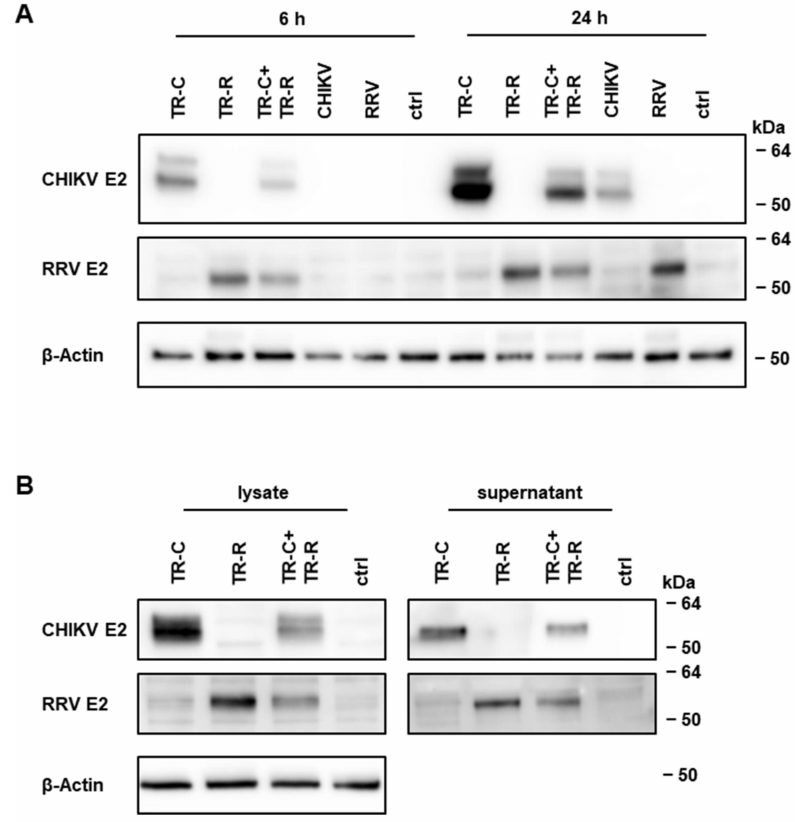
Figure 3. Antigen expression from TR-RNAs. ( A ): CHIKV E2 and RRV E2 protein expression in cellular lysates 6 h and 24 h after transfection of 2 µ g of replicase-RNA together with 0.5 µ g of the indicated TR-RNAs. As control, cells were infected with CHIKV or RRV (MOI 3) or left untreated (ctrl). ( B ): Protein expression 48 h after transfection of 8 µ g of the replicase-RNA with 2 µ g of the indicated TR-RNAs in cellular lysates or concentrated supernatants. The depicted Western blots are representative of three independent experiments. Uncropped blots and densitometry readings are given in Supplementary Figures